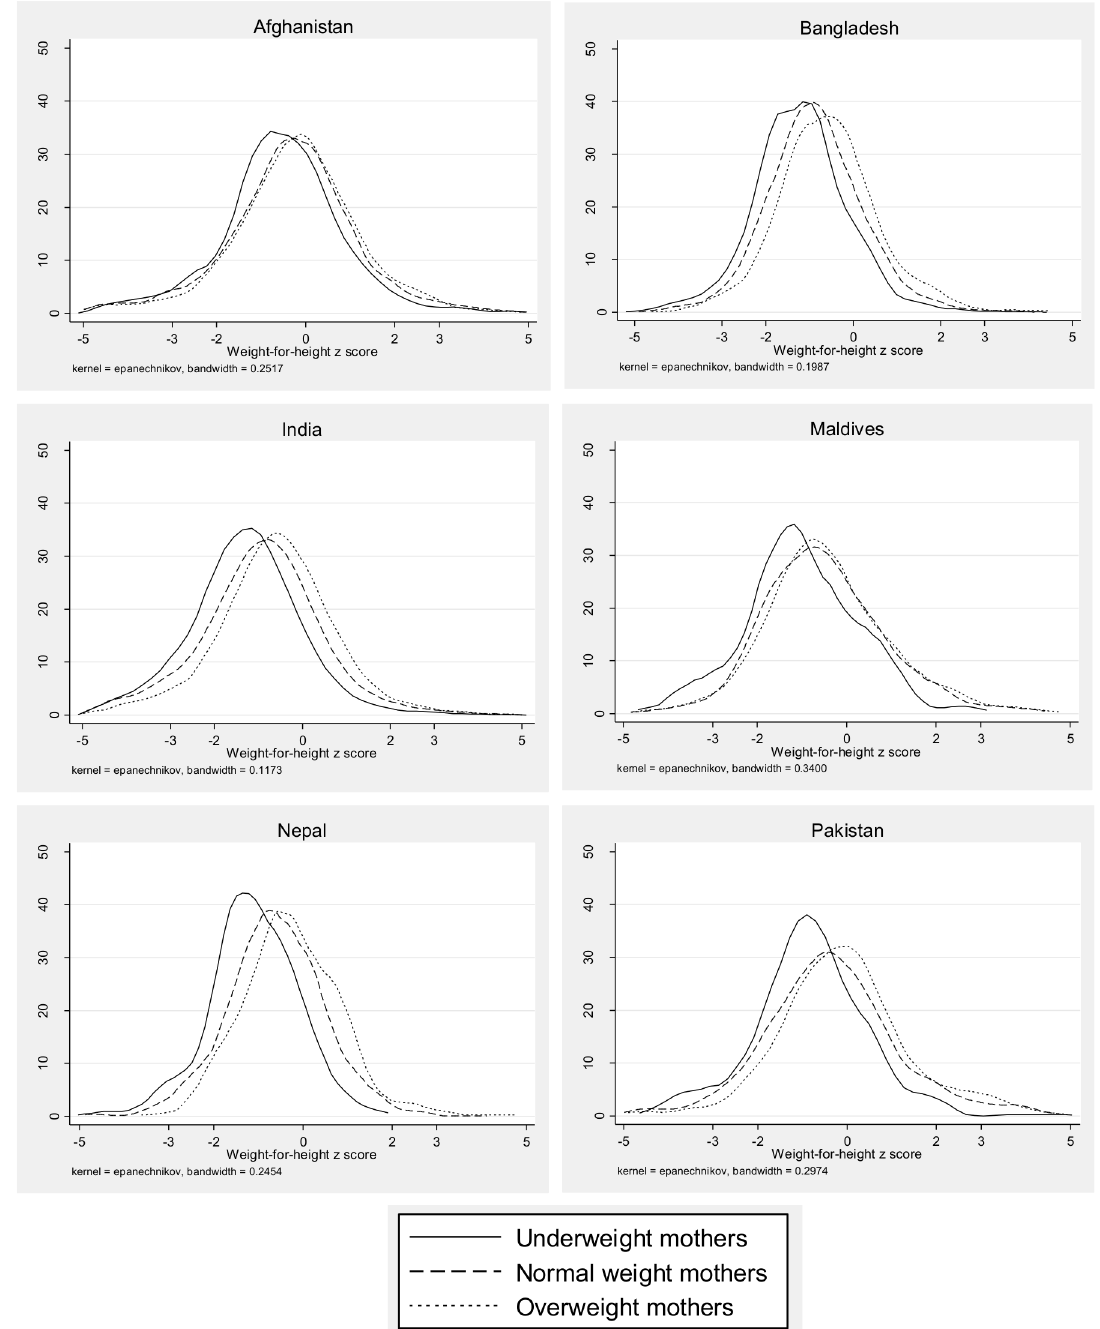
Fig 1. Kernal density estimates of WHZ by maternal BMI categories of under-, normal and over-weight, by country.